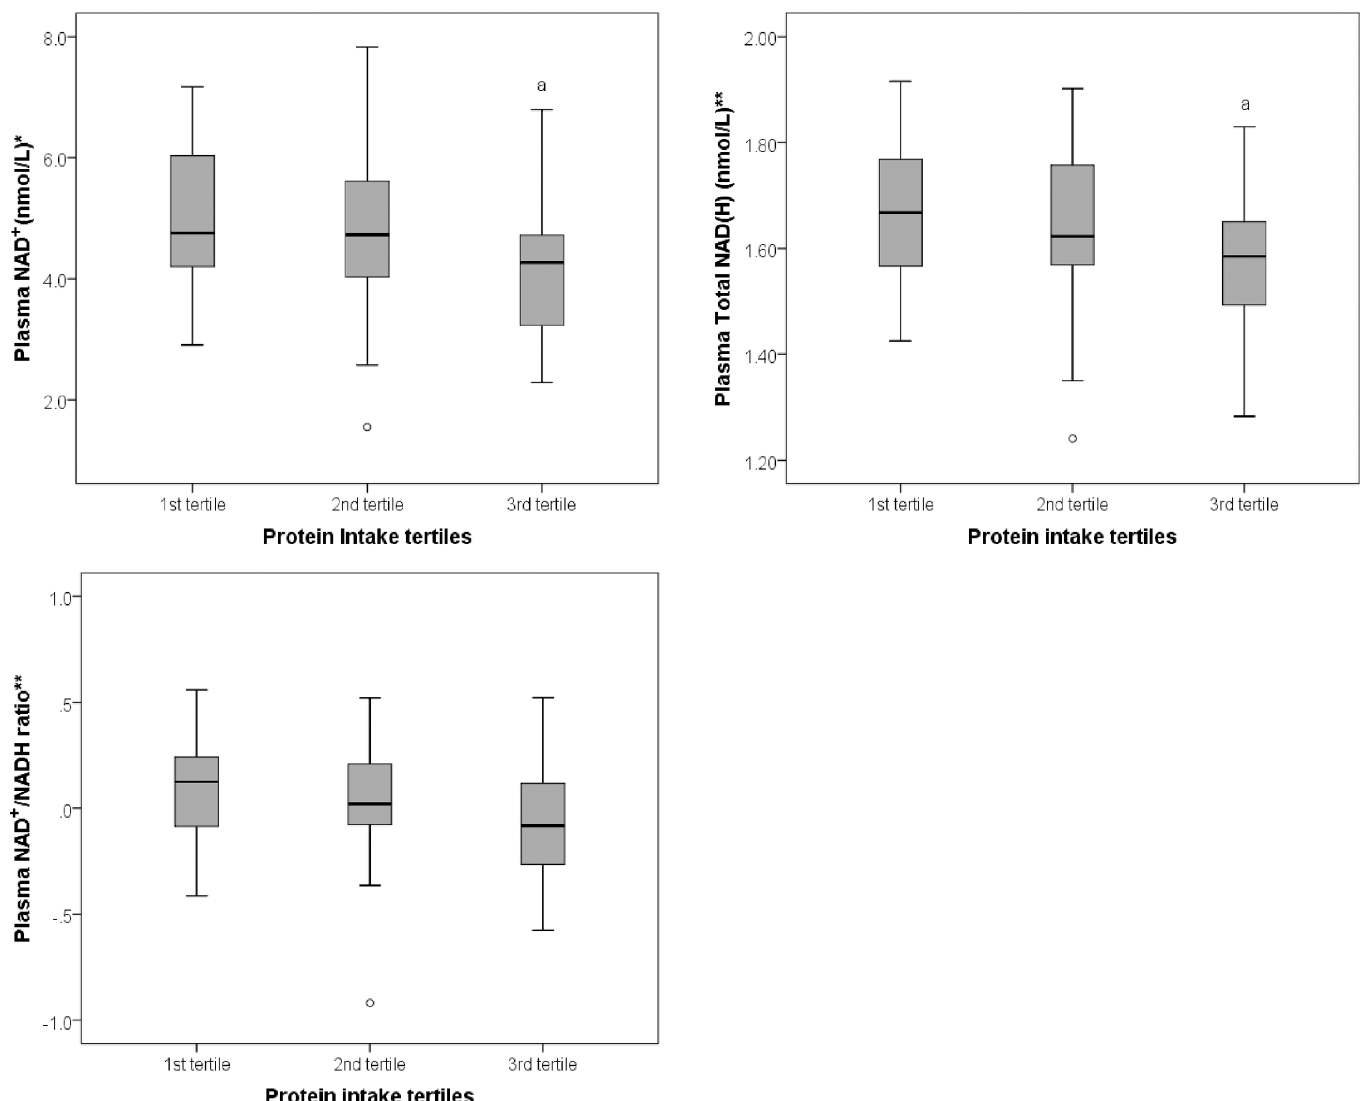
Fig 1. Mean plasma levels of NAD + , Total NAD(H), and NAD + /NADH ratio across tertiles of plasma urea. (cid:3) Data represented as square root NAD + , (cid:3)(cid:3) Data represented as base-10 log-transformed Total NAD(H), and NAD + /NADH ratio. a significantly different compared to 1 st